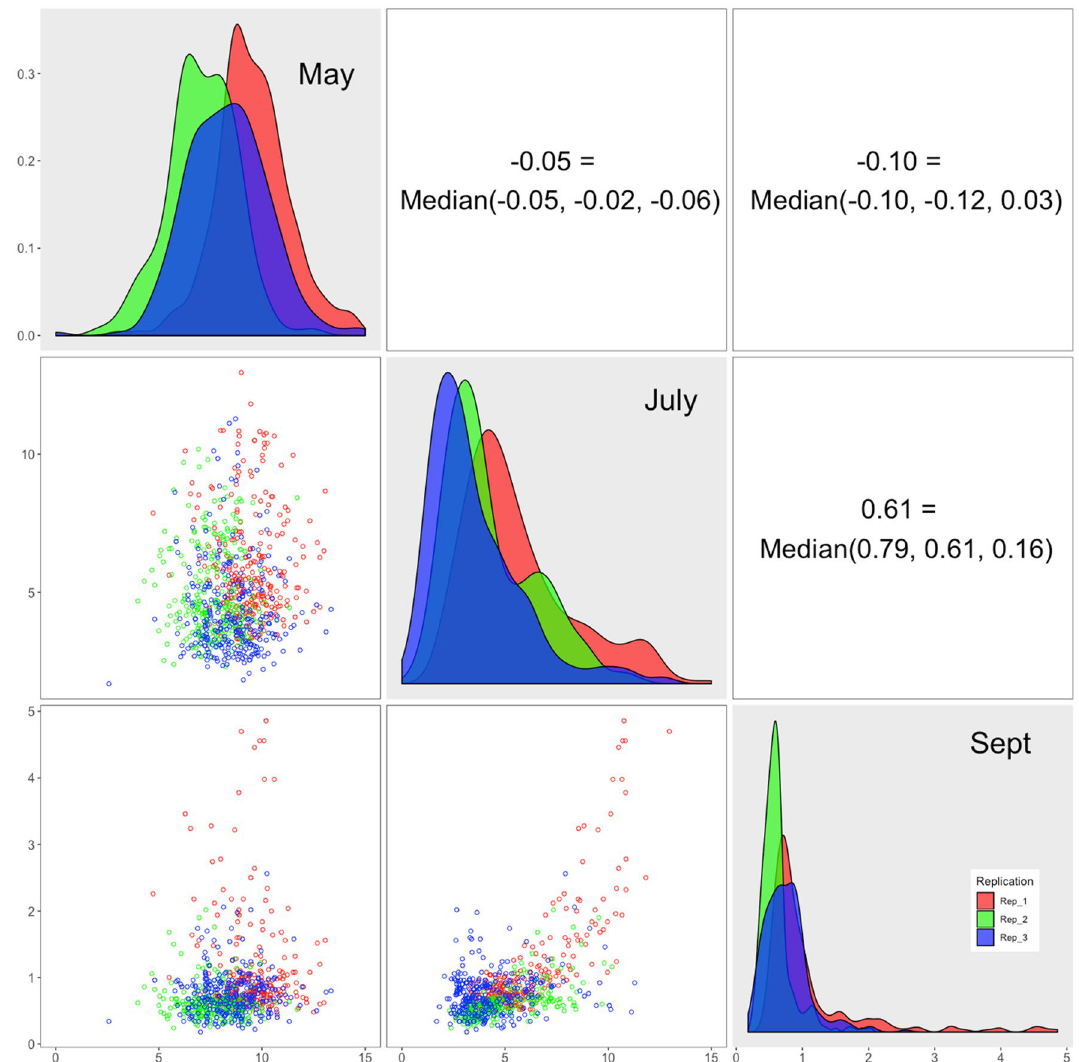
Figure 1. Distributions, scatter plots, and correlations among biomass harvested in May, July, and September of 2019. The distribution of biomass values is displayed on the diagonal for alfalfa plots harvested on May 6–7, July 8–9, and September 3–4, 2019, with replications indicated by colors. Replication 1 and 2 contained 269 plots; replication 3 contained 270 plots. The correlations among harvest months are displayed as scatter plots in the lower triangular area and as the Pearson correlation coefficients in the upper triangular